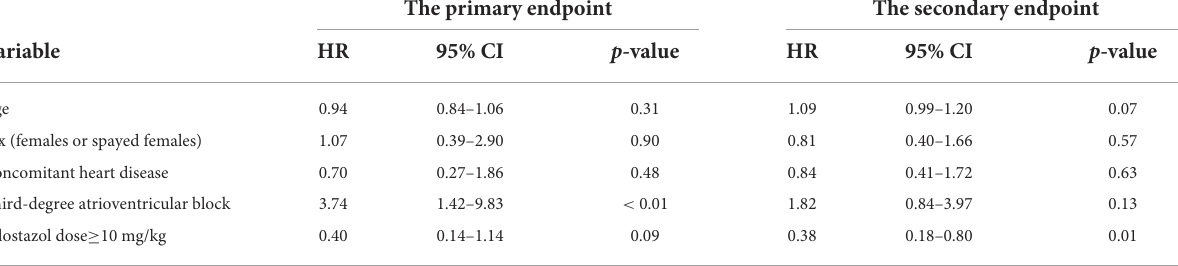
TABLE 6 Hazard ratio for reaching primary and secondary endpoints by univariate Cox proportional hazards analysis.